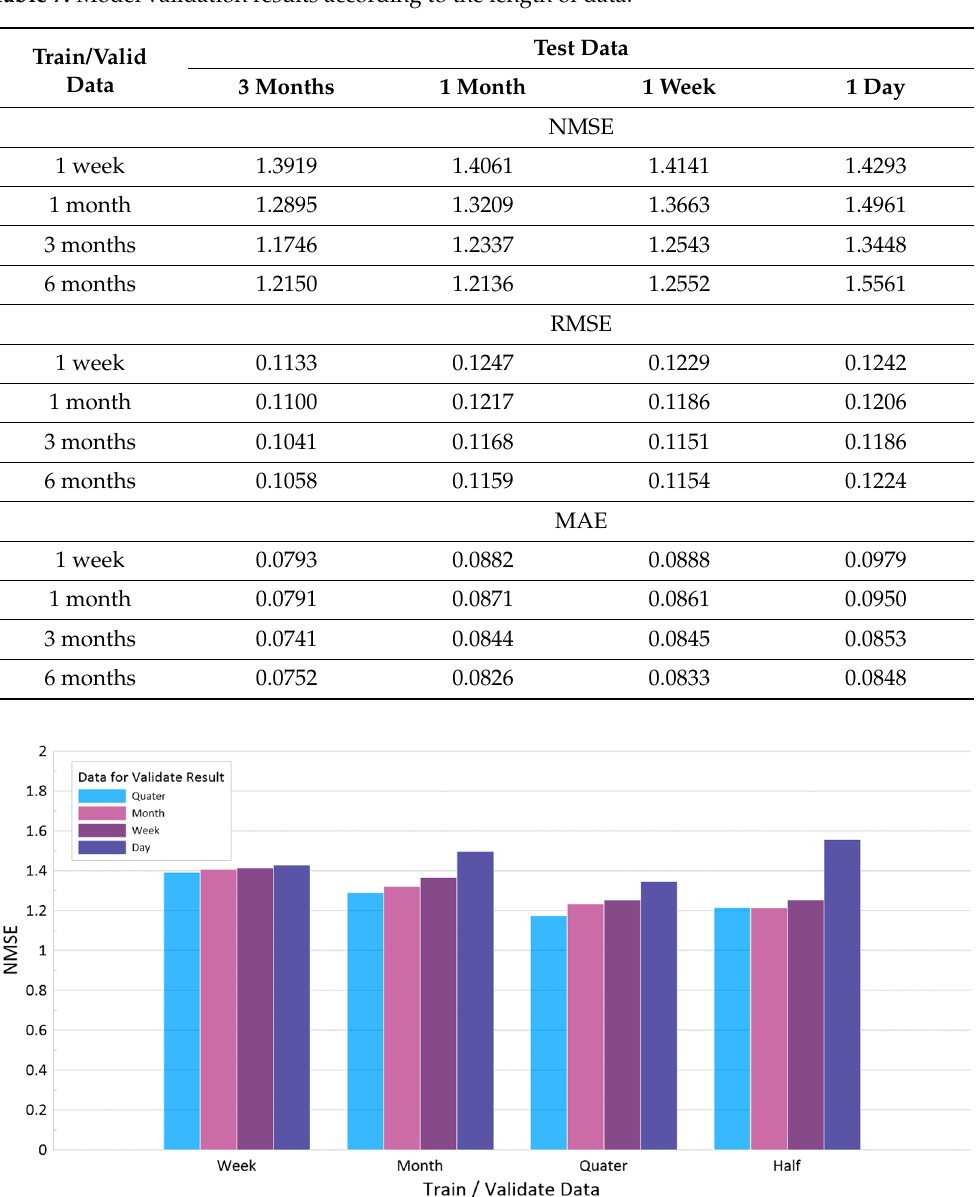
Figure 8. Model validation results according to the data for validated result length.